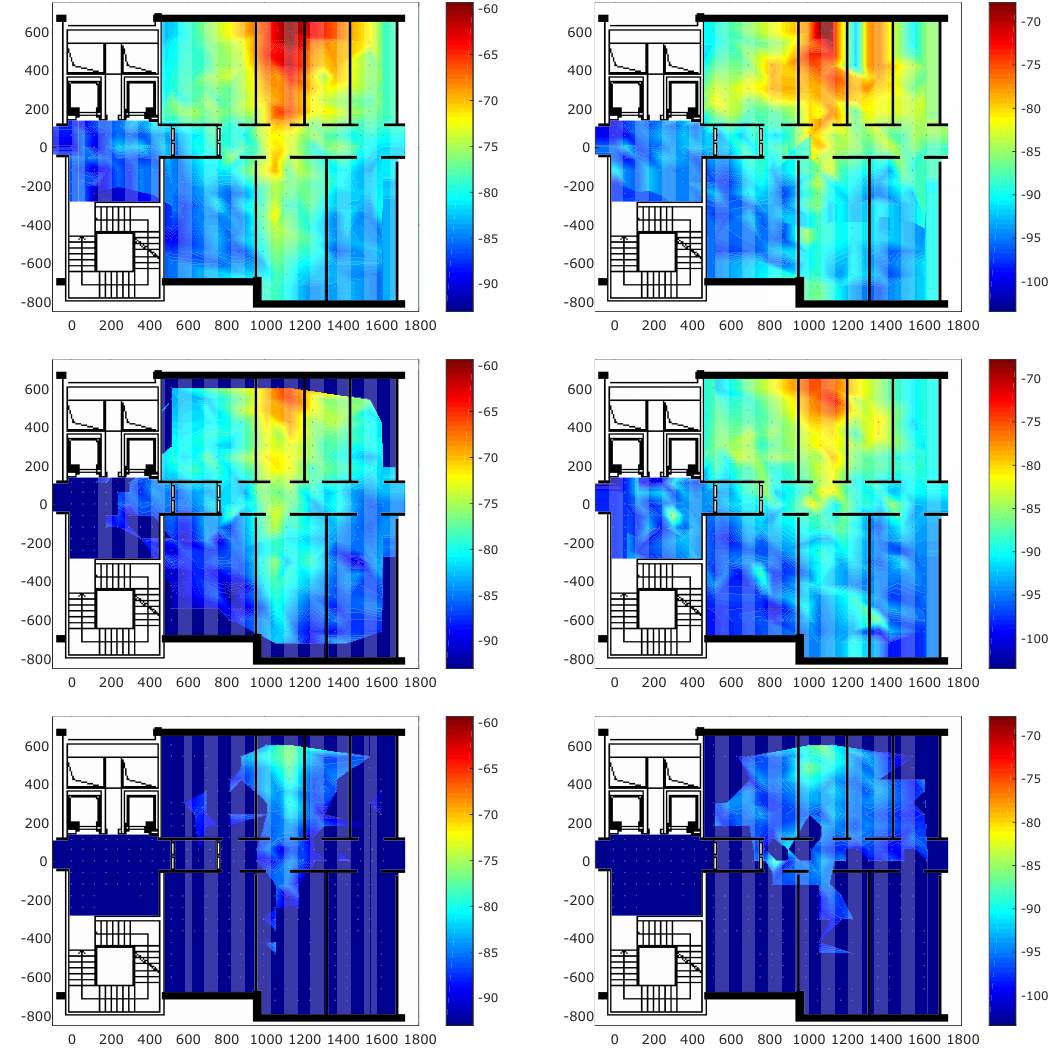
Figure 5. RSSI between Mobile 1 and the Anchor 1070 for both remote positioning ( left ) and self positioning configurations ( right ). From the top row to the bottom one, the transmission power values are 3 dBm, − 6 dBm, and − 18 dBm.